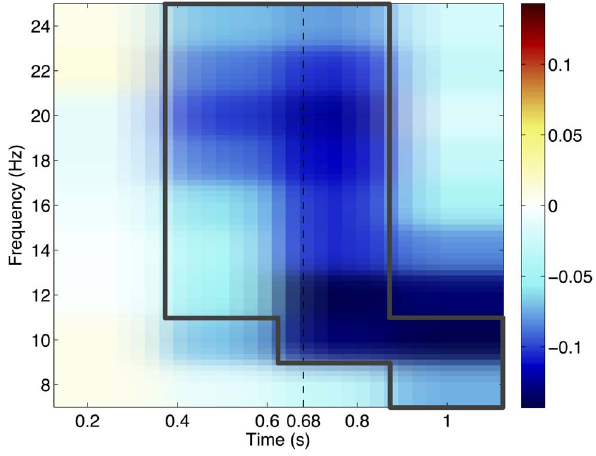
Figure 4. Grand Average ERP. Grand average Event Related Potential (ERP) results for the training block. Top: the ERPs for the related (solid red) and unrelated (dashed black) conditions. The grey area indicates where the conditions differ significantly. The dashed vertical line indicates the average reaction time, i.e., when the subjects pressed the button. Bottom: The distribution over the scalp of the significant difference (related – unrelated) averaged over the grey area of the top panel (260ms –1000 ms). Asterisks indicate for which channels the effect is significant.